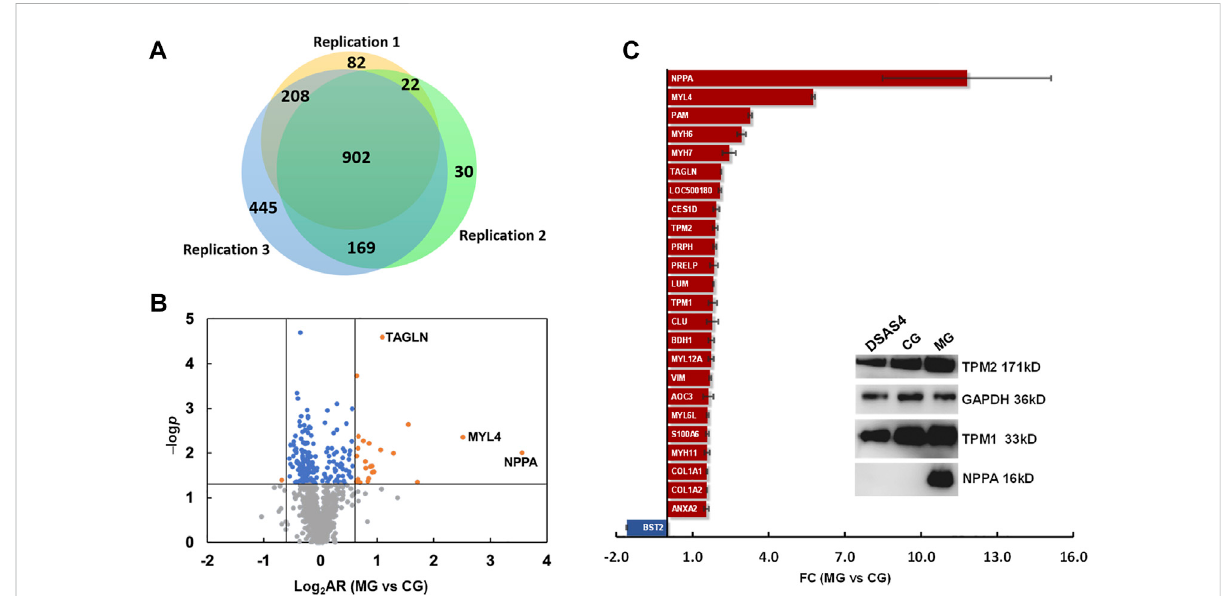
FIGURE 4 Differential expression proteomics of the heart of rats in the control group (CG) and ISO-iCM model group (MG). (A) Number of proteins identi fi ed in three parallel replicates. (B) Volcanic map of the proteins identi fi ed in both the control (CG) and model (MG) groups with various abundanceratios(ARs)and p -values. Orange point refers to aproteinwith alog 2 AR (MG vs. CG)of ≥ 0.59 or ≤ − 0.59and a p -value of < 0.05;blueto a protein with a log 2 AR of > − 0.59 or < 0.59 and a p -value of < 0.05, gray to a protein with a p -value of > 0.05. (C) Fold changes (FCs) of 25 differentially expressed proteins in the heart of the model group (MG) compared to those in the control group (CG). The insert is the Western blotting bands of the representatives of DEPs, NPPA, TMP1, and TMP2 in the heart of rats in CG, MG, and the treated group with Descurainia sophia seeds decoction plus astragaloside IV (DSAS4). GAPDH was used as an internal